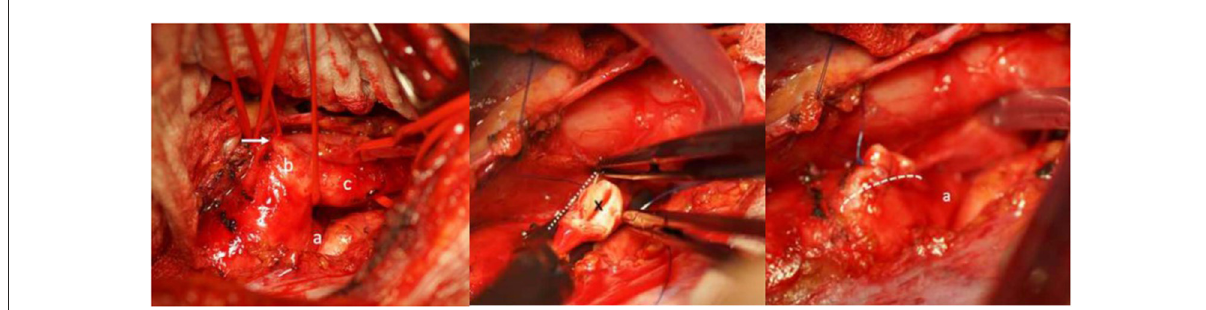
FIGURE5 Left: Intraoperative view showing the distal aortic arch (a), the large Kommerell diverticulum (b) and the left subclavian (lusorian) artery (c). The white arrow shows the ductus ligament. Middle: The abnormal left subclavian artery has been transected from the Kommerell diverticulum at its origin (*), the aortic arch is clamped tangentially and the Kommerell diverticulum resected. Right: Picture after resection of the Kommerell diverticulum and longitudinal suture (dotted line) of the aortic arch. A) represents the aortic arch coming from posteriorly. Reproduced with permission from Cardiovasc Med: w10132: doi 104414.